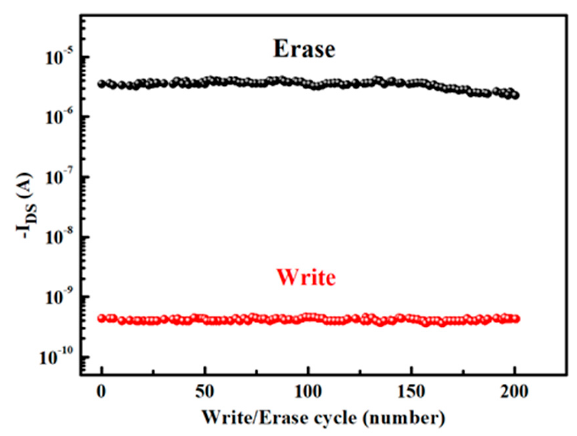
Figure 8. Figure 8. Endurance characteristic of OTFMT device with graphene oxide (GO) as the charge-storage layer.